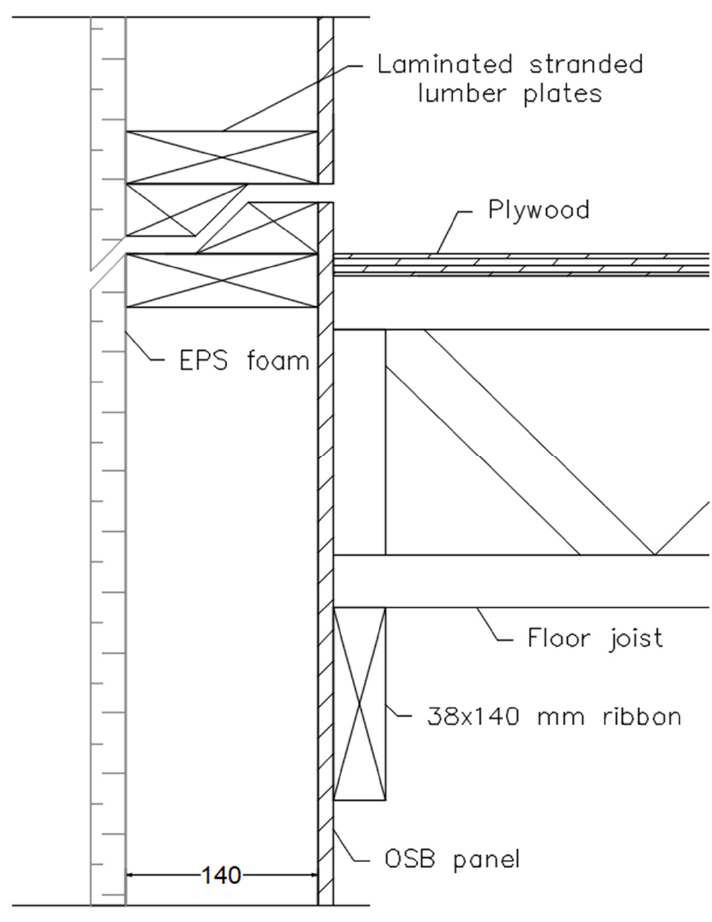
Figure 2. System developed using light wood frame structure.